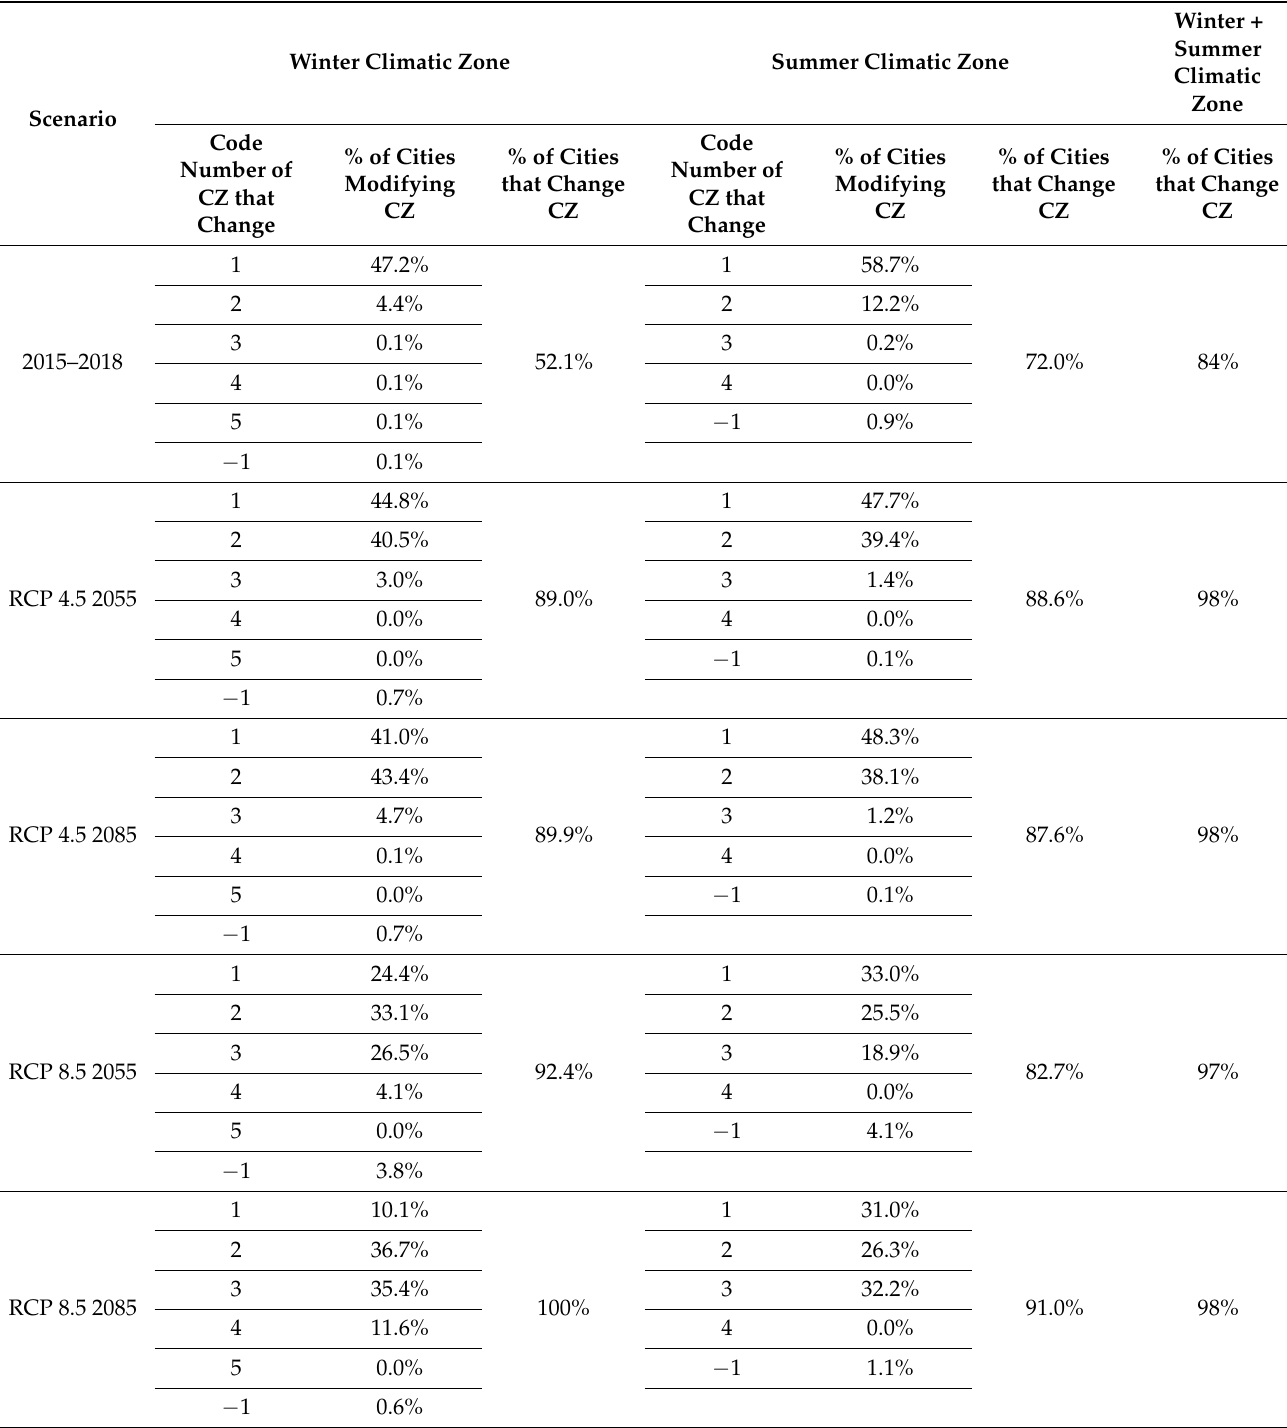
Table 3. Dynamics of changes in climate zones according to